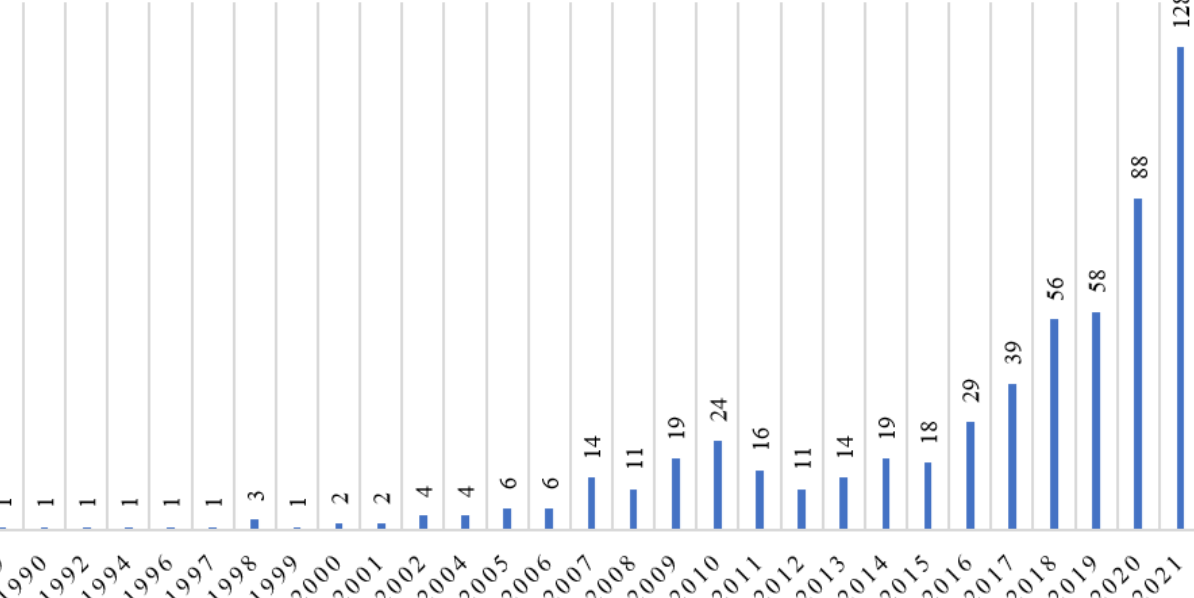
Figure 3. The number of studies per year.